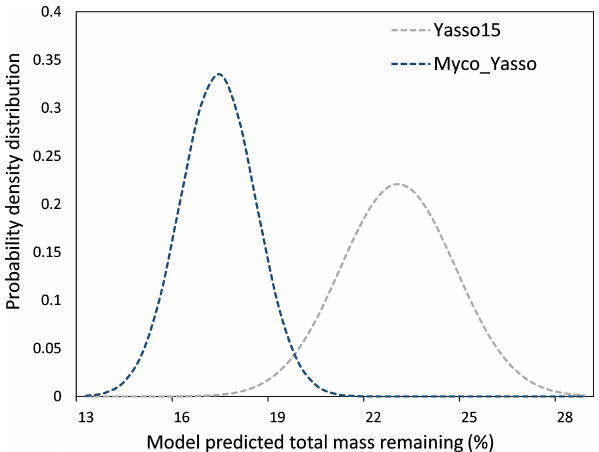
Figure 5. The probability density distribution of litter mass remain- ing as predicted by Yasso15 compared to Myco_Yasso. Compared to predictions of Yasso15, Myco-Yasso reduces the variation in the predictions of C mass remaining from decomposing litter af- ter 10 years of decomposition. The probability density is based on 1000 model runs for conditions of a hypothetical site with the pre- scribed environmental conditions (see descriptions in Sect.